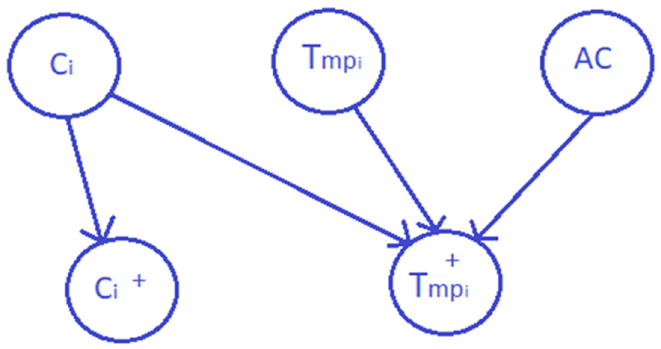
Figure 4. State transition diagram.